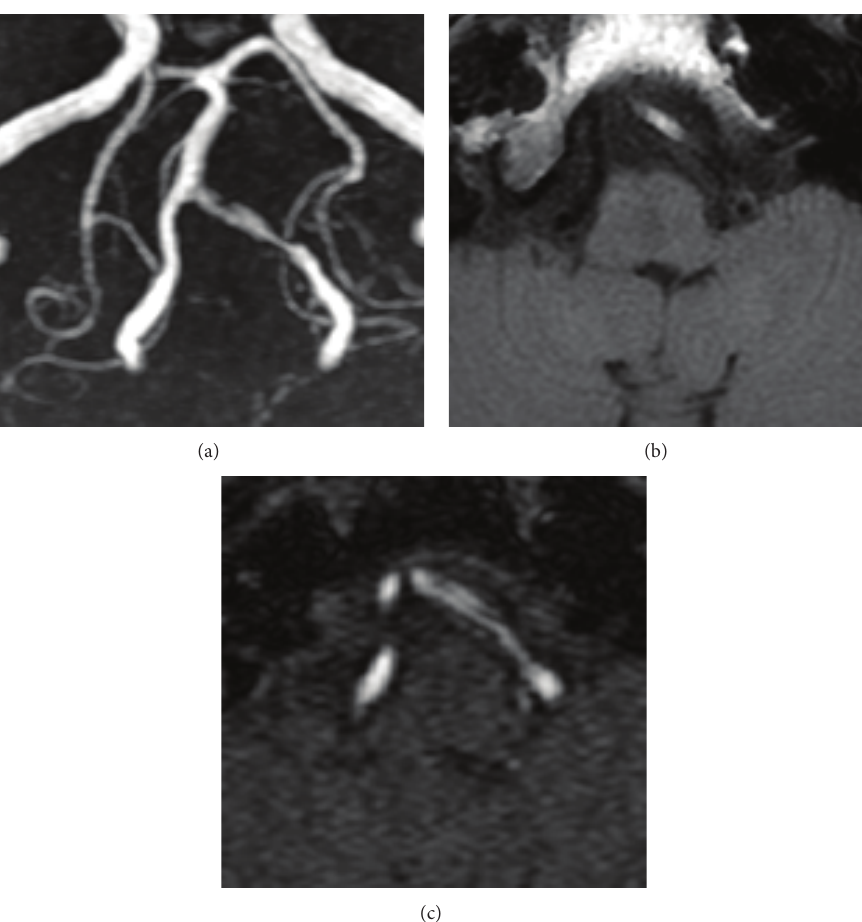
Figure 1: (a) Time-of-flight magnetic resonance angiography (MRA) of the left vertebral artery on admission reveals irregular narrowing of the lumen and a surrounding high-intensity area suggestive of a false lumen or intramural hematoma. (b) The T1-weighted image of MRI demonstrates a high-intensity area in the vessel wall, indicating intramural hematoma. (c) The source image of the MRA demonstrates a linear low-intensity structure presumed to be the intimal flap that separates 2 high-intensity